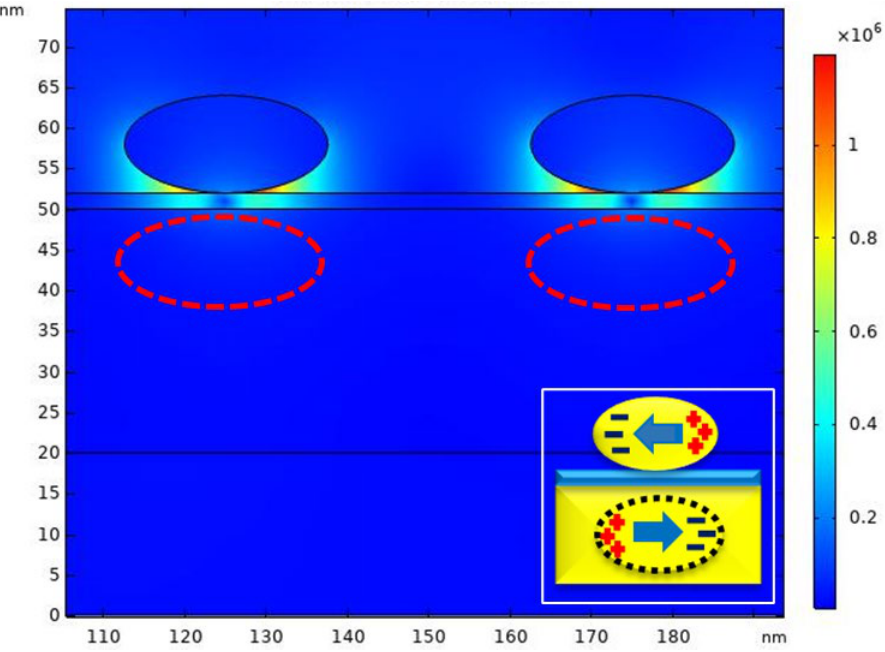
Figure 3. The normal component of the electric field intensity.